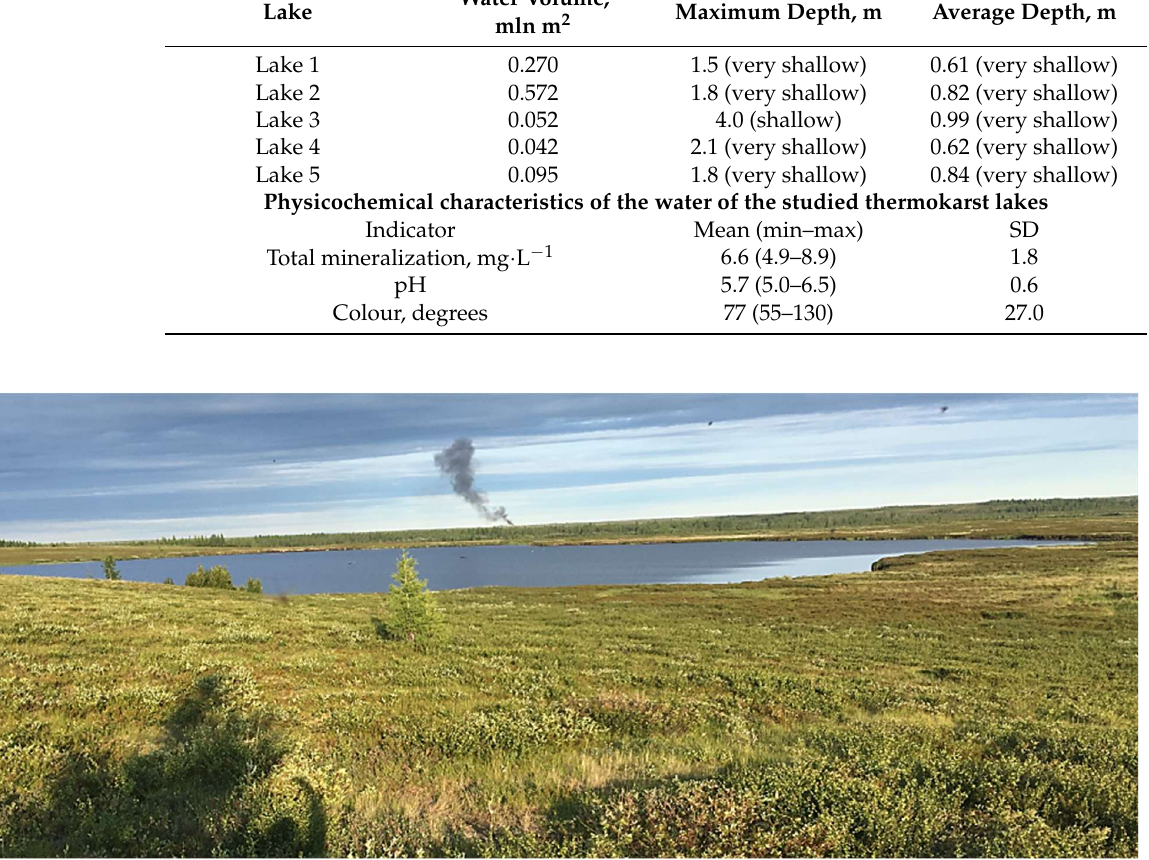
Figure 5. Typical unnamed thermokarst lake of the Tazov Peninsula with industrial activity in the background.